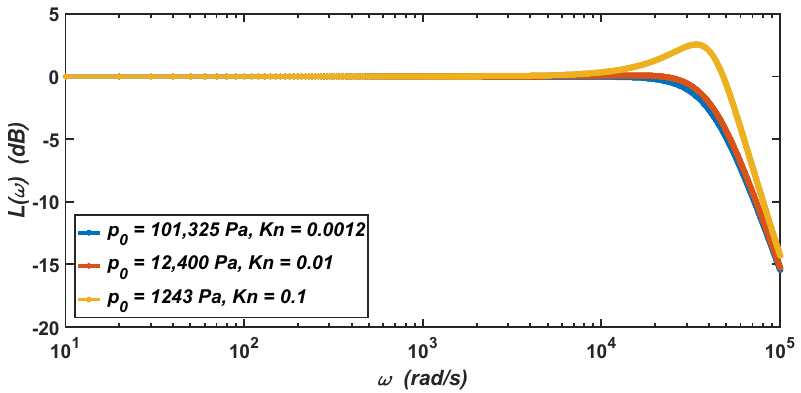
Figure 8. The logarithmic amplitude–frequency characteristics of the micro-accelerometer when the air pressure drops from the standard atmospheric pressure to 1243 Pa.